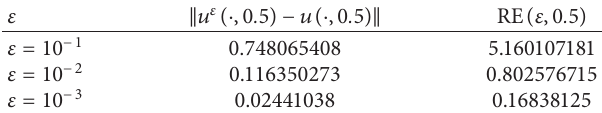
Table 1: The error of the proposed